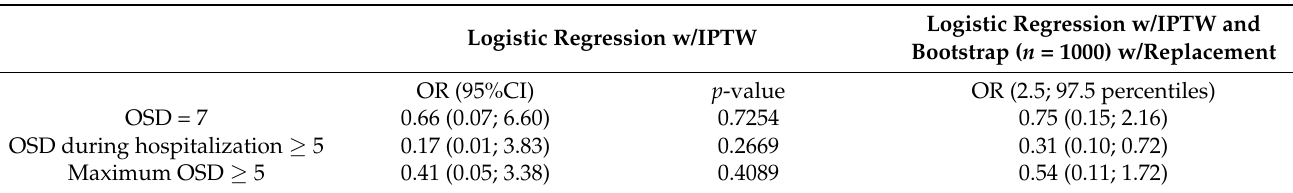
Table 3. Logistic regression analysis with IPTW for outcomes in terms of OSD by biologic prescription. Logistic Regression